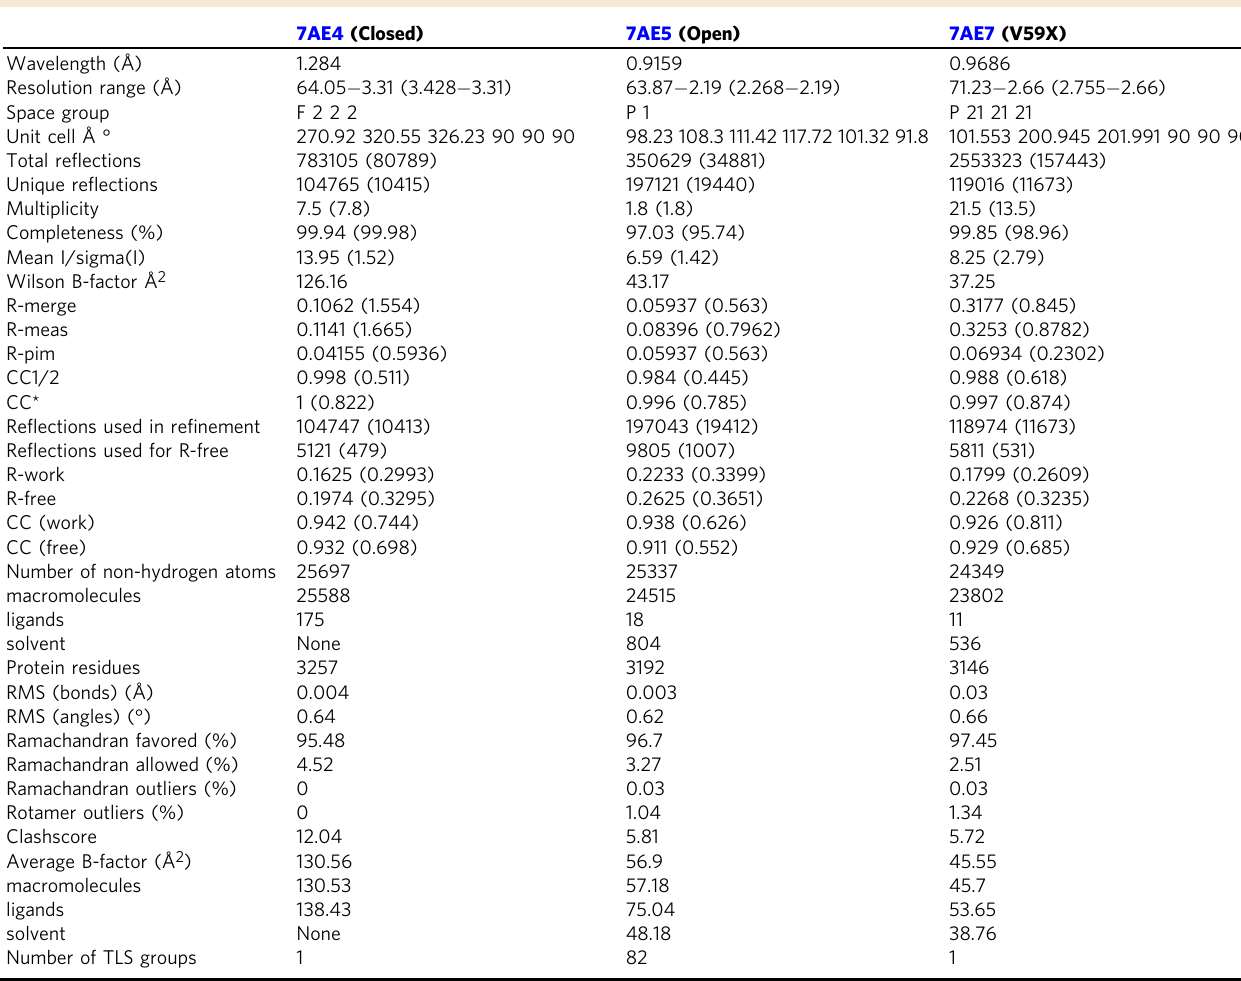
Table 1 X-ray crystallography data collection and re fi nement